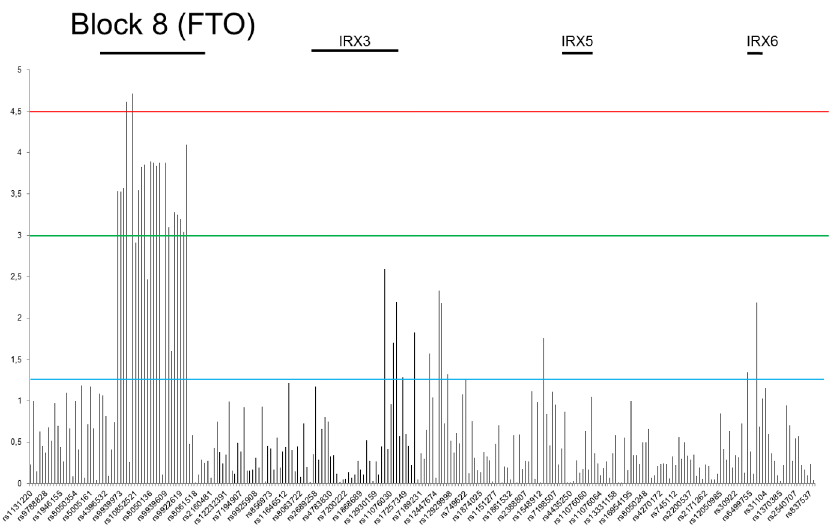
Fig 5. Distribution of calculated p values in linear regression analysis. P values are expressedas negativelogarithmof the p values obtained in linear regression analysiswith age and sex as a covariates. The y axis shows the − log 10 p values of 262 SNPs, and the x axis shows their rs numbers. Horizontalblue, green and red lines represent the thresholdsof p = 0.05 for significancewithout multiple correction, p = 8.2E-04 for LD block significanceand p = 1.9E -04 for Bonferroni correction,